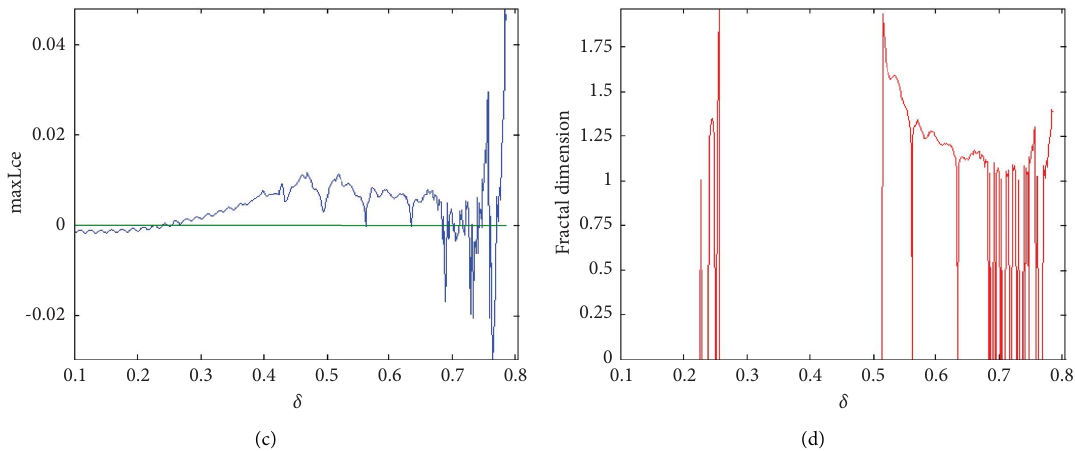
Figure 4: NS bifurcation diagrams of system (4) for δ : (a) in prey, (b) local amplifcation in prey, (c) MLEs, and (d) FD.